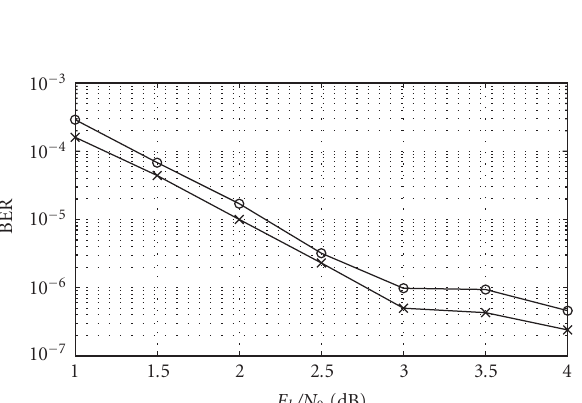
Figure 10: Modified OFDM receiver.